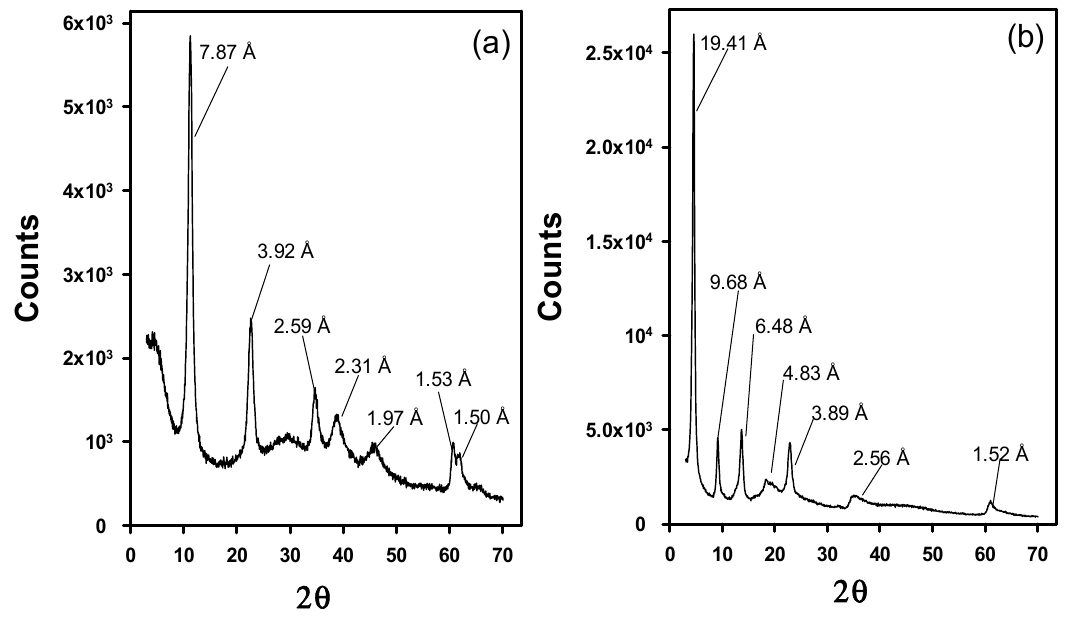
Figure 3. X-Ray Di ff raction patterns of Cl-LDH ( a ) and WA-LDH ( b Figure 3. X-Ray Diffraction patterns of Cl-LDH ( a ) and WA-LDH ( b ).